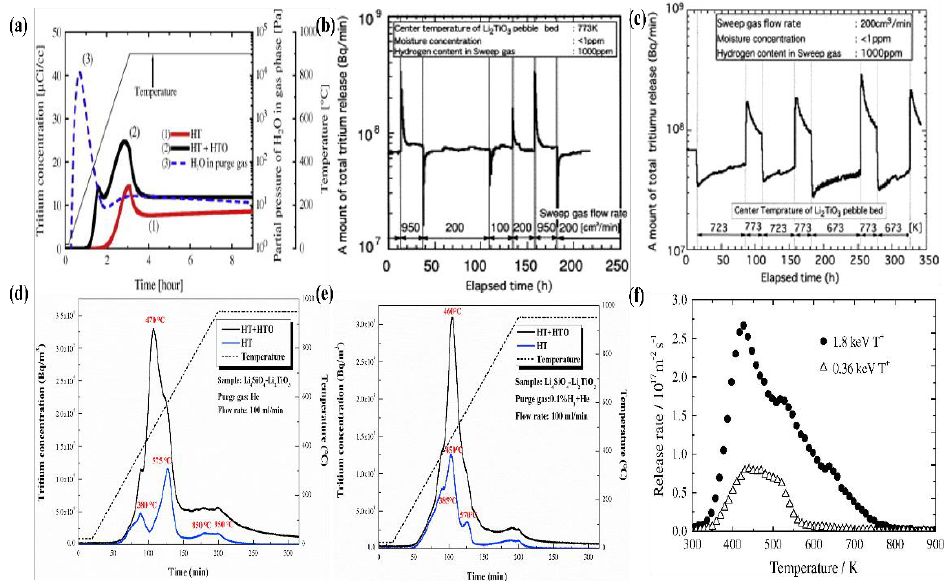
Figure 6. ( a ) A simulation result of tritium and water release. Reprinted with permission from ref. [92]. ( b ) Example of change in tritium release when changing the scavenging flow rate. ( c ) Tritium precipitation when changing the center temperature of the Li 2 TiO 3 pebble layer. Reprinted with permission from ref. [93]. ( d ) The tritium release curve of Li 2 TiO 3 -Li 4 SiO 4 biphasic pebbles under He purge gas. ( e ) The tritium release curve of Li 2 TiO 3 -Li 4 SiO 4 biphasic pebbles under 0.1%H 2 + He purge gas. Reprinted with permission from ref. [94]. ( f ) Purge gas dependency on tritium release behaviors for T + implanted Li 2 TiO 3 . Reprinted with permission from ref. [95].